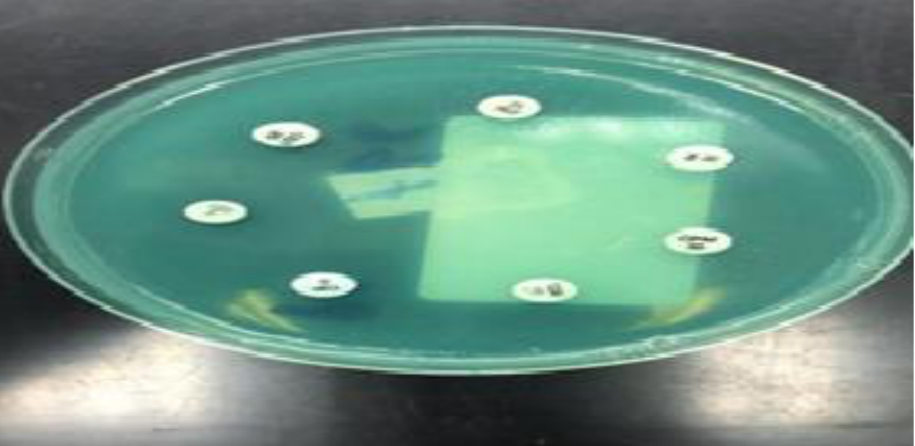
Figure 5. A plate of Muller-Hinton agar inoculated by P. aeruginosa showing extensive drug